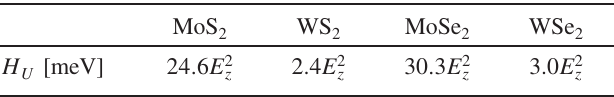
is expressed in z